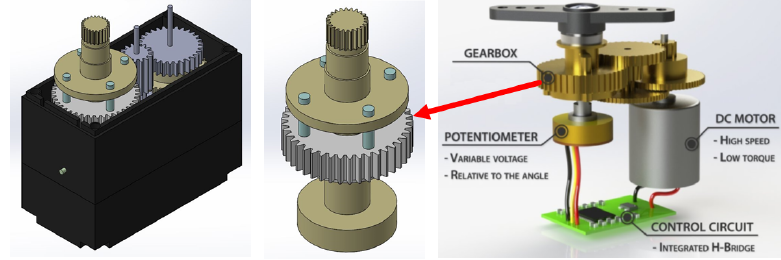
Figure 1. Basic structural elements of a simple standard robot servo and the elastic